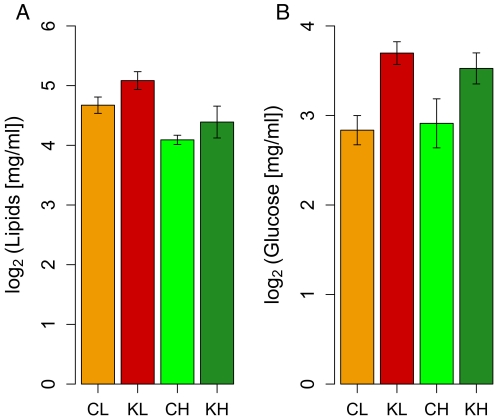
Abdominal lipid and hemolymph glucose levels at 11 days of age.A: overall, abdominal lipids were significantly affected by genotype (factorial ANOVA: genotype, F(1,40) = 4.3019, 13.9294, p = 0.00059) and treatment (factorial ANOVA: treatment, F(1,40) = 4.3019, p = 0.04455). B: overall, glucose levels in the hemolymph were significantly affected by treatment (factorial ANOVA, treatment, F(1,59) = 14.89, p = 0.0002849) but not by genotype (factorial ANOVA, genotype, F(1,59) = 0.006, p = 0.9395109). No significant interaction effects were observed for either lipid or glucose levels. Barplots represent means ± s.e. Orange: low pollen hoarding genotype control (CL); red: low pollen hoarding genotype knockdown (KL); light green: high pollen hoarding genotype control (CH); dark green: high pollen hoarding genotype knockdown (KH).